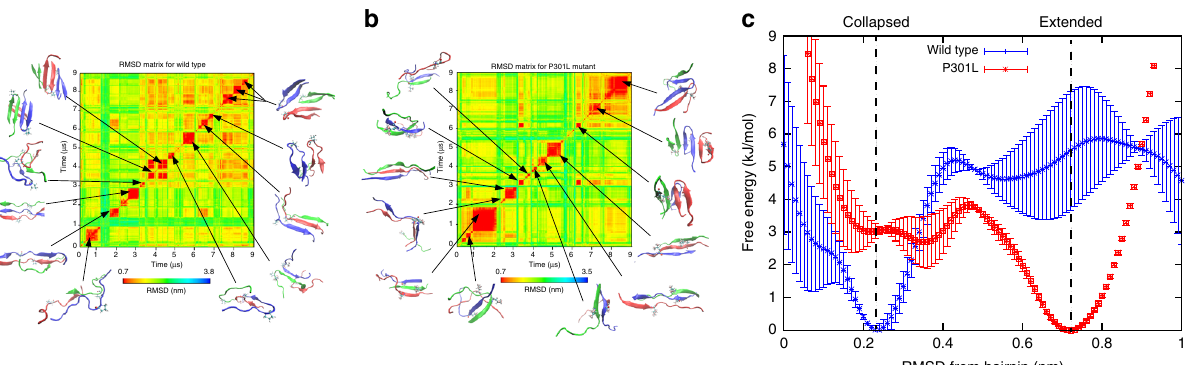
Fig. 3 Wild-type and mutant peptides differentially populate collapsed and extended conformations. a Trimer conformations obtained from MD simulations of WT peptide fragment (R2R3-WT) with the sequence 295 DNIKHVPGGGSVQIVYK 311 . Two-dimensional root mean-squared-differences (RMSD ’ s) are calculated between all pairs of conformations visited during MD simulations. Snapshots of trimeric structures are depicted for selected metastable basins, with each peptide monomer represented by a different color. b The same analysis as in a , but for the P301L substituted trimer. c The free-energy surface as a function of deviation from a canonical hairpin structure. Two distinct basins, corresponding to collapsed and extended sub-ensembles, are found in WT and P301L peptide fragment, respectively. Error bars represent a 95% CI of each RMSD